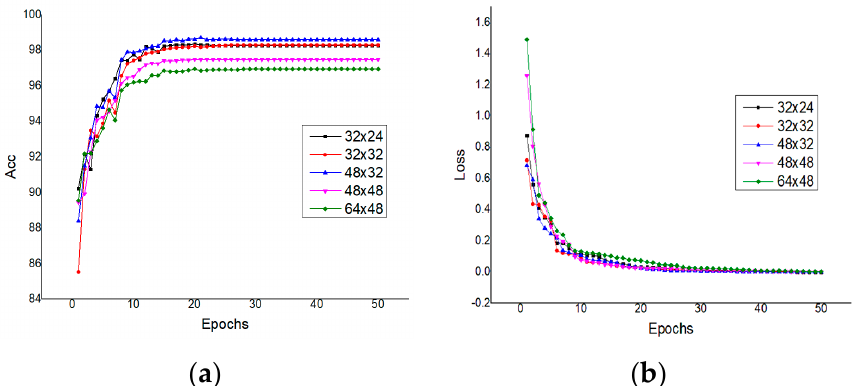
Figure 8. The performance of the CNN classification model in the Validation set. Subfigure ( a ) the accuracy changing curve of the CNN classification model; Subfigure ( b ) the average loss changing curve of the CNN classification model.